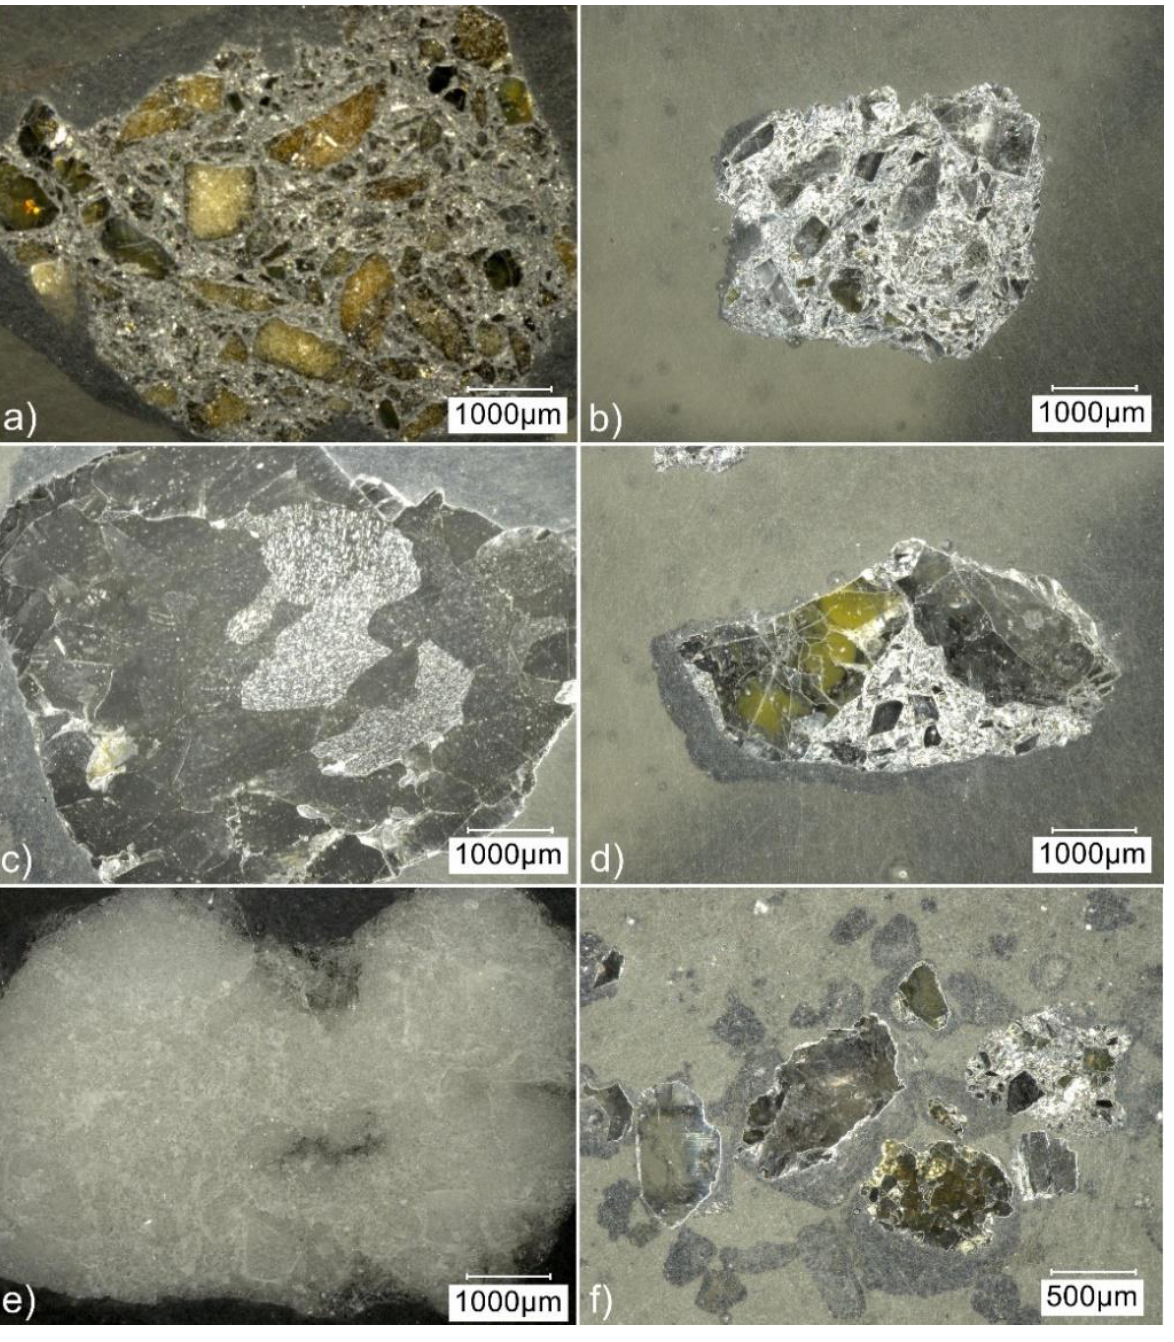
Figure 3. Optical micrographs of polished sections of recyclate aggregates from the size fractions ( a , c , e ) 3 – 6 mm, ( b , d ) 1 – 3 mm, and ( f ) 0 – 1 mm.